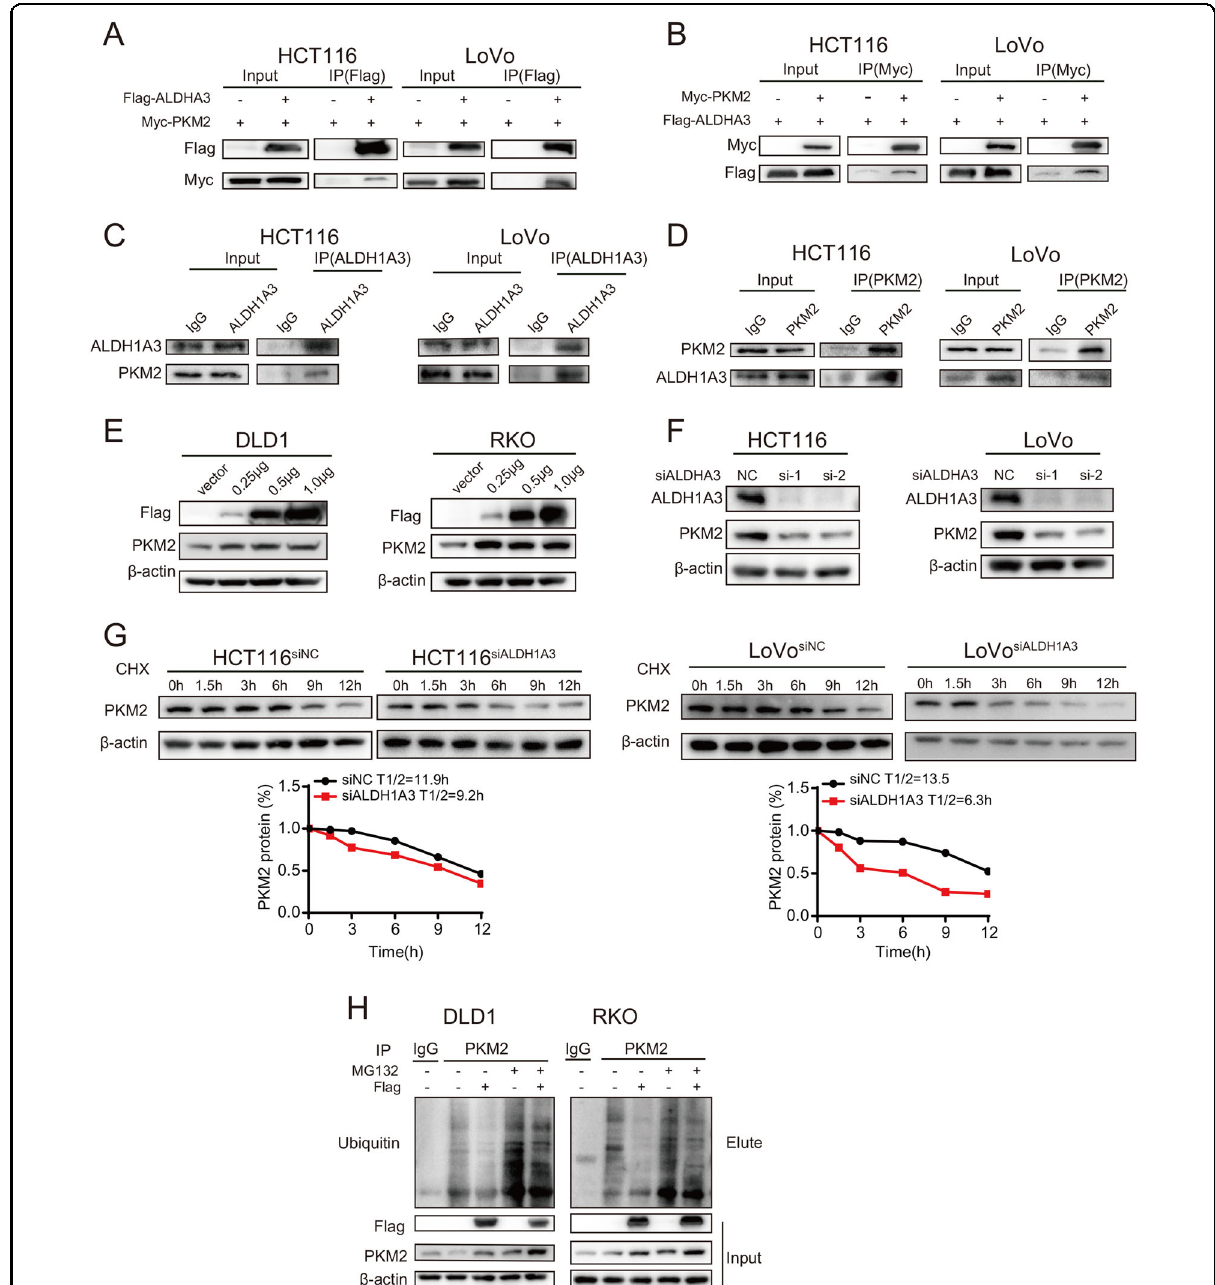
Fig. 6 ALDH1A3 directly interacts with PKM2 and inhibits its ubiquitination. a , b HCT116 and LoVo cells were co-transfected with Flag-tagged ALDH1A3 and Myc-tagged PKM2 and subjected to IP of Flag ( a ) or Myc ( b ). c , d Reciprocal co-IP of ALDH1A3 ( c ) and PKM2 ( d ) showing the physical interaction between endogenously expressed ALDH1A3 and PKM2 in HCT116 and LoVo cells. e Ectopic expression of ALDH1A3 increased the PKM2 protein levels in DLD1 and RKO cells. f After siALDH1A3 was transfected, PKM2 protein expression was decreased in HCT116 and LoVo cells. g HCT116 and LoVo cells were transfected with siALDH1A3 or its control, then incubated with 100 mg/ml Cycloheximide (CHX). The levels of PKM2 and β -actin were detected by immunoblotting at the indicated time (up panel), and quanti fi cation of PKM2/ β -actin ratio is shown (down panel) . h ALDH1A3 increased the PKM2 level by inhibiting its ubiquitin-mediated